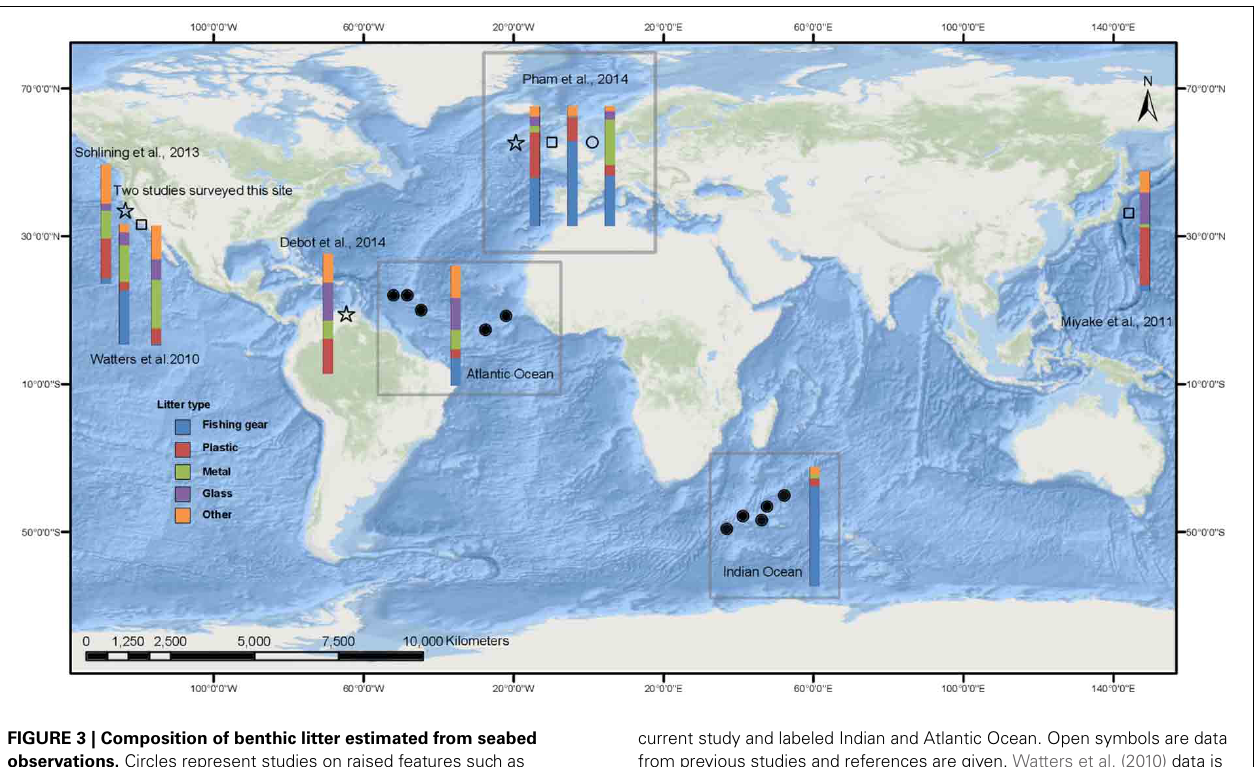
current study and labeled Indian and Atlantic Ocean. Open symbols are data from previous studies and references are given. Watters et al. (2010) data is given for two areas along the California coast. European data, reviewed by Pham et al. (2014) is summarized for the three physiographic types.